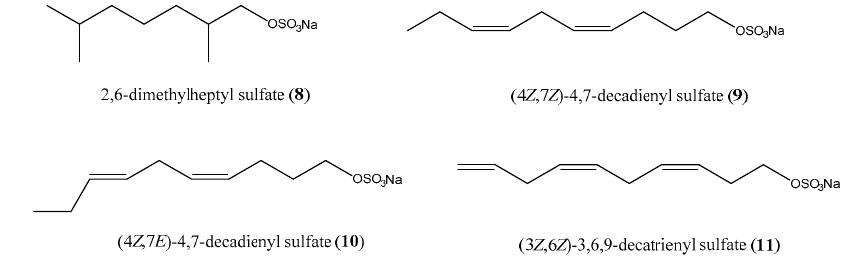
Figure 3. Structures of alkyl and alkenyl sulfates 8 – 11 .